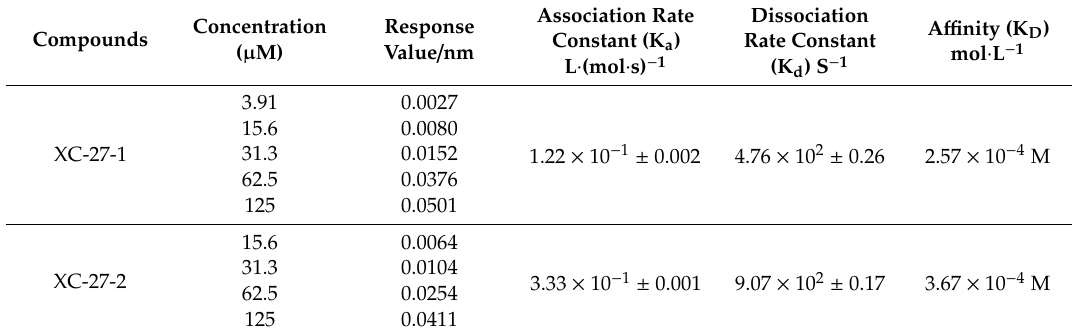
Table 2. The binding a ffi nity parameters for the interaction between the derivatives and HA.